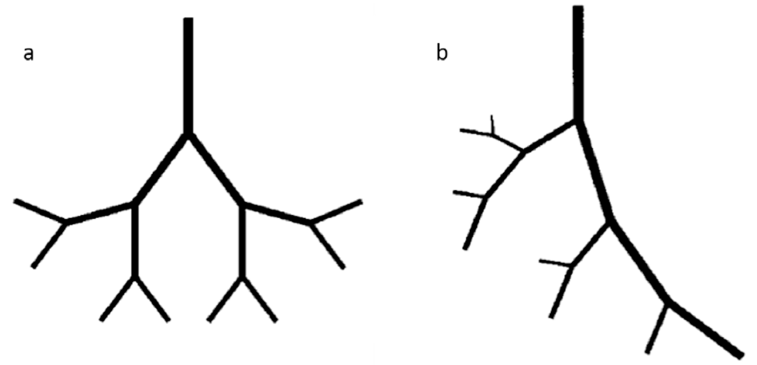
Figure 12. Fractal representation of a symmetrical bifurcation ( a ) and a non-symmetrical bifurcation ( b ) of a vascular tree. Reprinted from Fractal Dimensions and Multifractility in Vascular Branching, M. Zamir, J. Theor. Biol. (2001) 212, 183–190 (Issue 2), Copyright (2001), with permission from Elsevier [150].